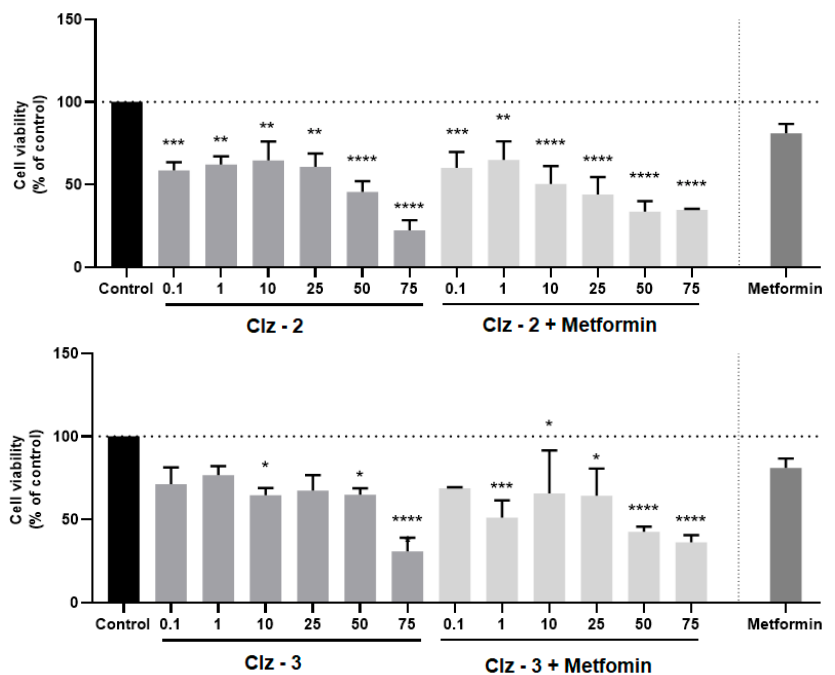
Figure 6. Relative viabilities of PC-3 cells after 72-h incubations of various concentrations of either just Clz–1, Clz–2, and Clz–3, or each Coelenterazine derivative combined with Metformin (1.27 µ